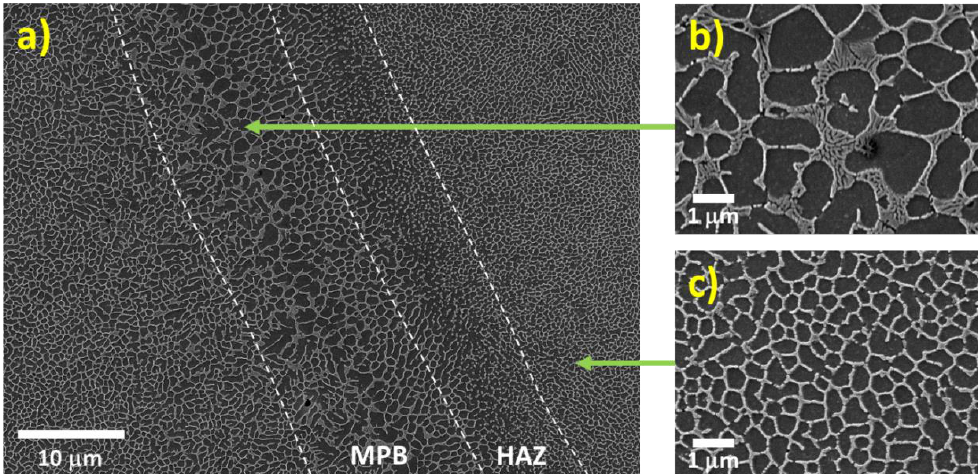
Figure 3. ( a ) Secondary electron image representing the microstructure of additively manufactured Al-Si alloys (AlSi10Mg). The surface parallel to the building platform is represented here. Similar features can be observed in the surface perpendicular to the building platform, but the shape of the cells is more elongated in that case. ( b ) Higher magnification image of a zone in the melt pool border. ( c ) Higher magnification image of a zone within the melt pool. MPB—melt pool border; HAZ—heat- affected zone. (Adapted from reference [43]).